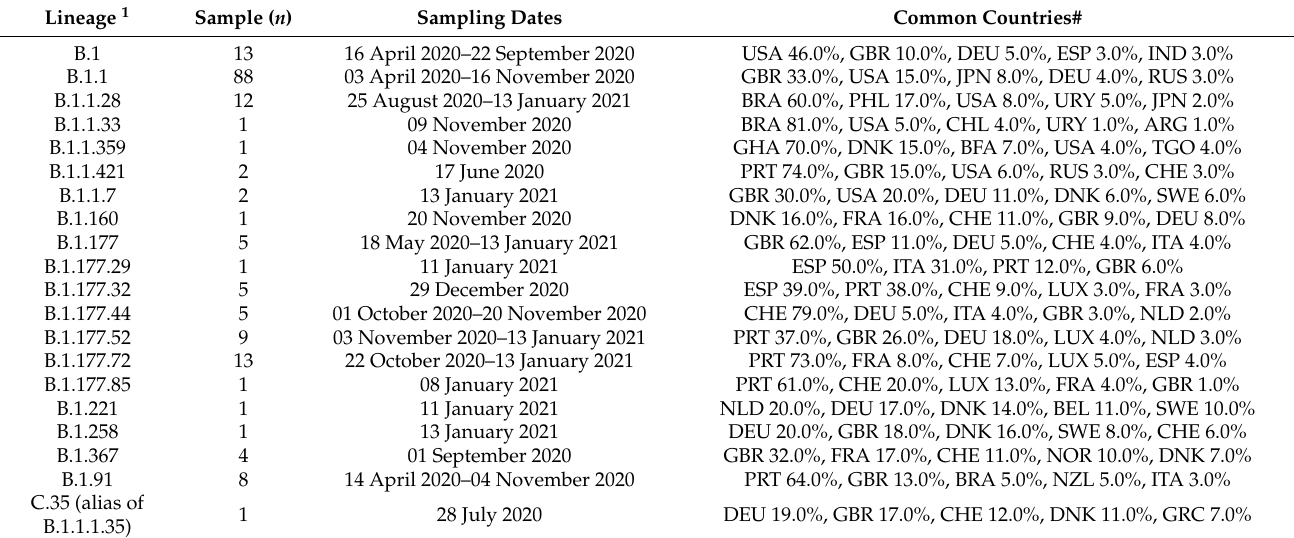
Table 2. Lineage in 174 SARS-CoV-2 positive nasopharyngeal samples randomly selected for sequencing.